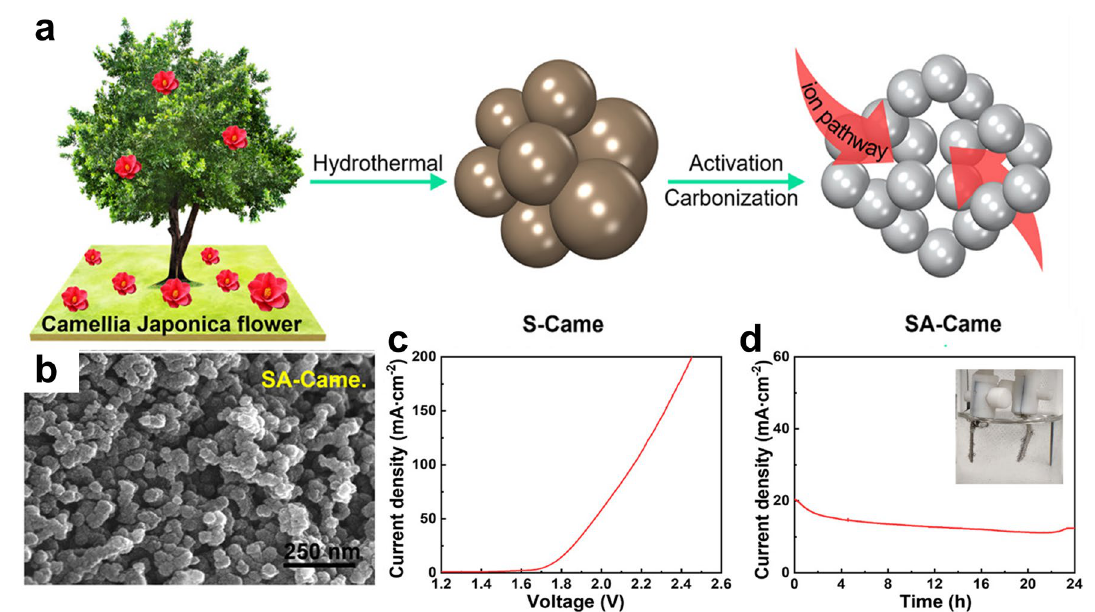
Fig. 12 a Scheme of the preparation of SA‑Came nanospheres. b SEM image of SA‑Came. c LSV curve and d Chronoamperometry analysis of the SA‑Came assisted water electrolyzer [174]. Copyright 2022,